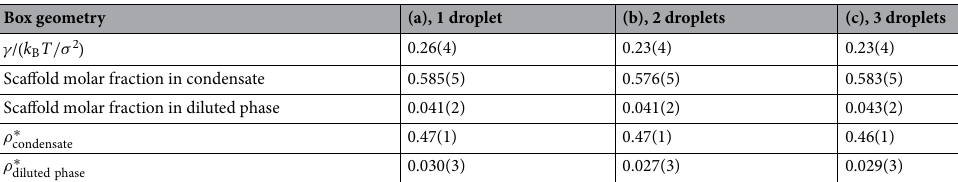
Table 2. Properties of systems presented in Fig. 2 containing 50:50 scaffold–surfactant compositions in different simulation box geometries. In all cases, 6 independent simulations (with different initial velocity distributions), each starting from a pre-equilibrated configuration, were performed. For the geometries with more than one droplet, the values are averaged over the different droplets, although the variance between distinct droplets is significantly small as shown in Fig. 2 (Bottom